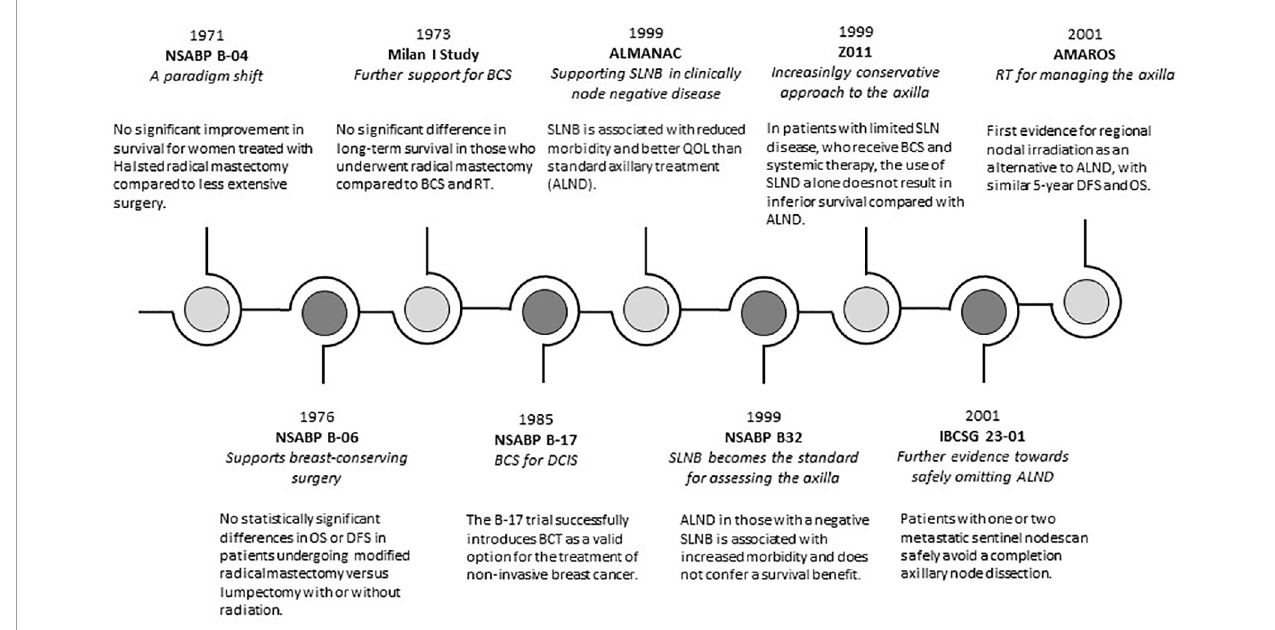
FIGURE 1 | A timeline of evolving trends in surgical management of breast cancer. OS, overall survival; DFS, disease free survival; BCS, beast conserving surgery; RT, radiotherapy; QOL, quality of life; SLNB, sentinel lymph node biopsy; ALND, axillary lymph node